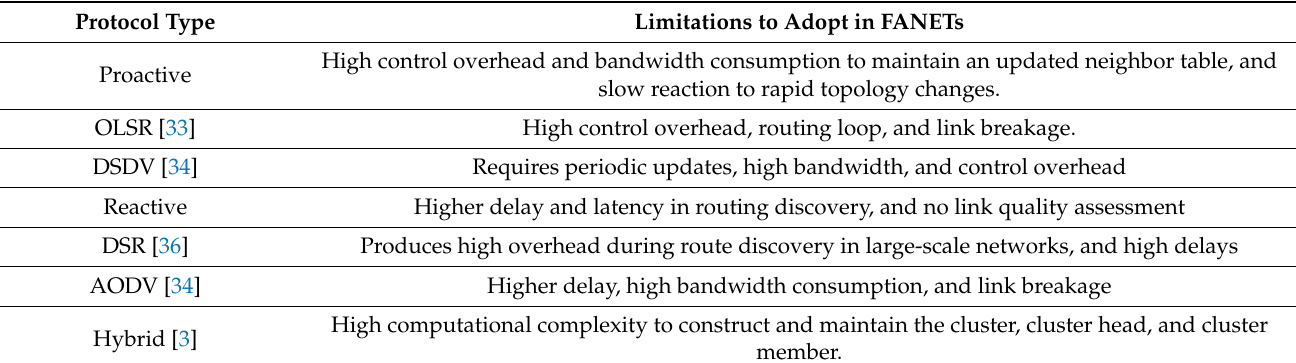
Table 2. Summary of topology-based routing protocols and their limitations in FANETs.